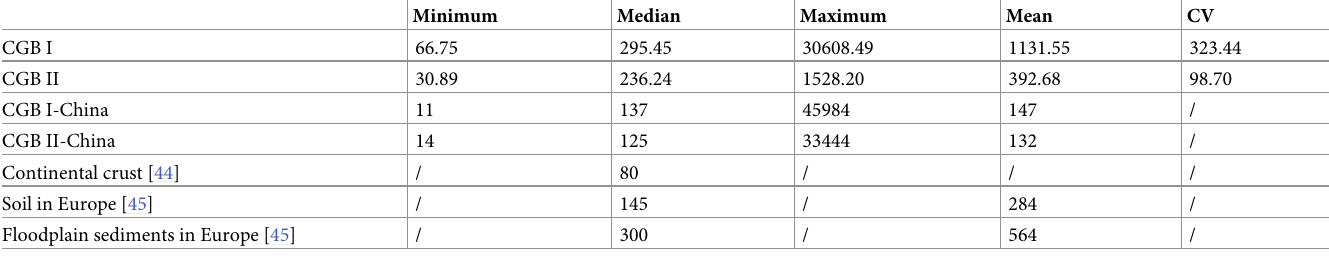
Table 1. Descriptive statistical analysis of